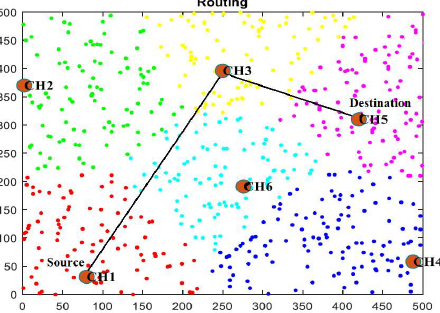
Figure 2. Data path from the source node CH1 to the destination node CH5.